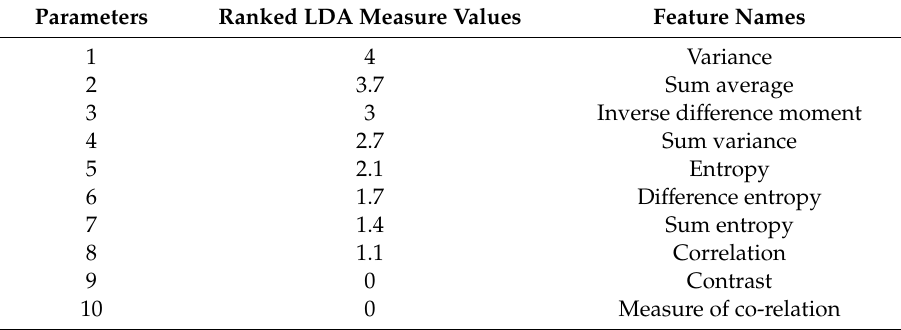
Figure 20. Graphical analysis of each feature selected via LDA using GLCM features. Table 3. GLCM feature analysis using LDA.